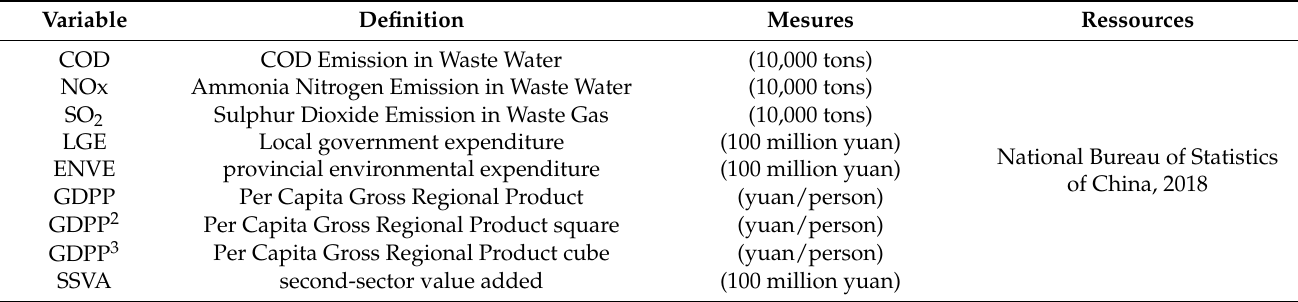
Table 1. The study